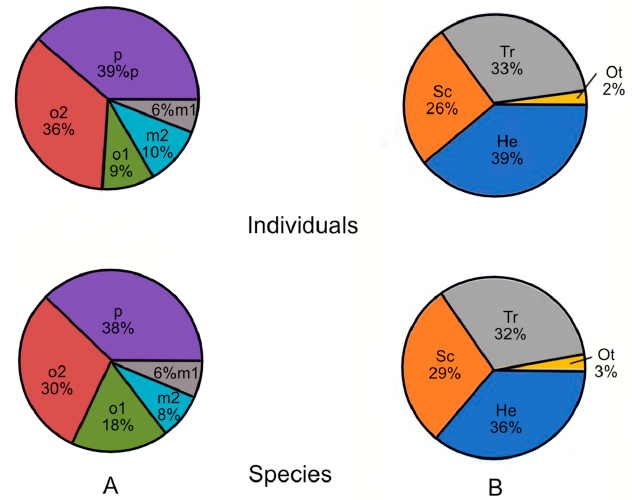
Figure 4. Number of individuals and species according to their larval host plant specificity ( A ) and